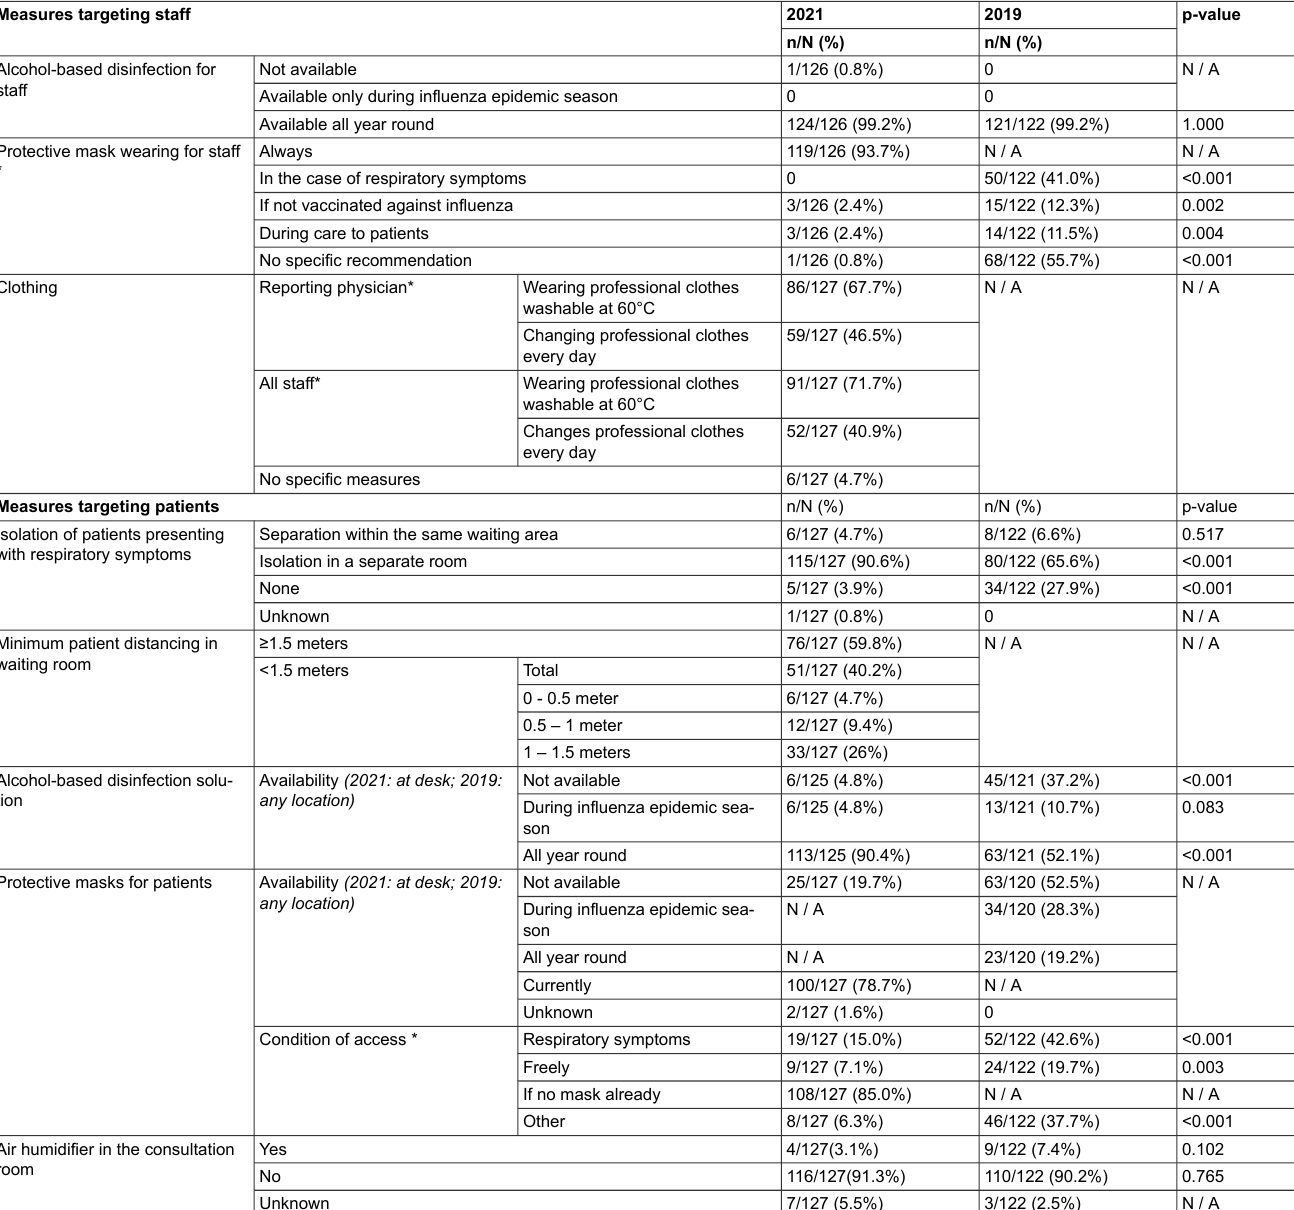
Table 2: Infection prevention and control measures in the Sentinella network in 2021 and 2019 (127 and 122 answering practices, respectively). Measures targeting